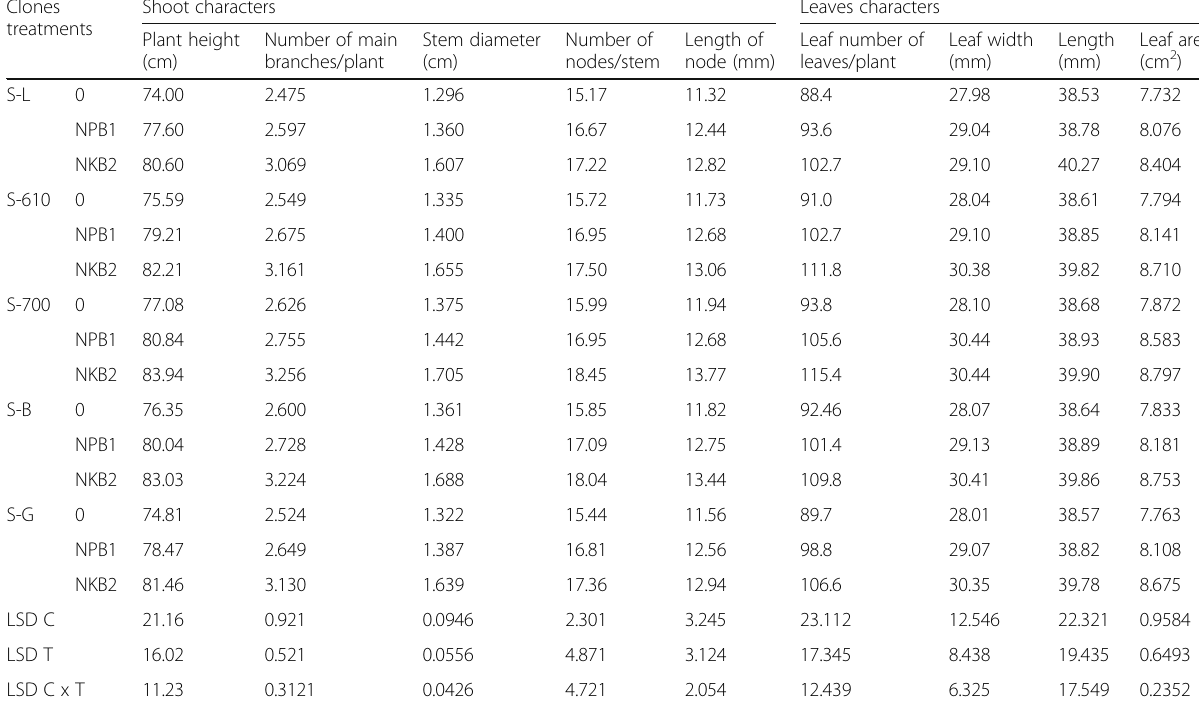
Table 2 Effect of rates of NPB on growth characters of clones jojoba plants at 3 years Clones Shoot treatments